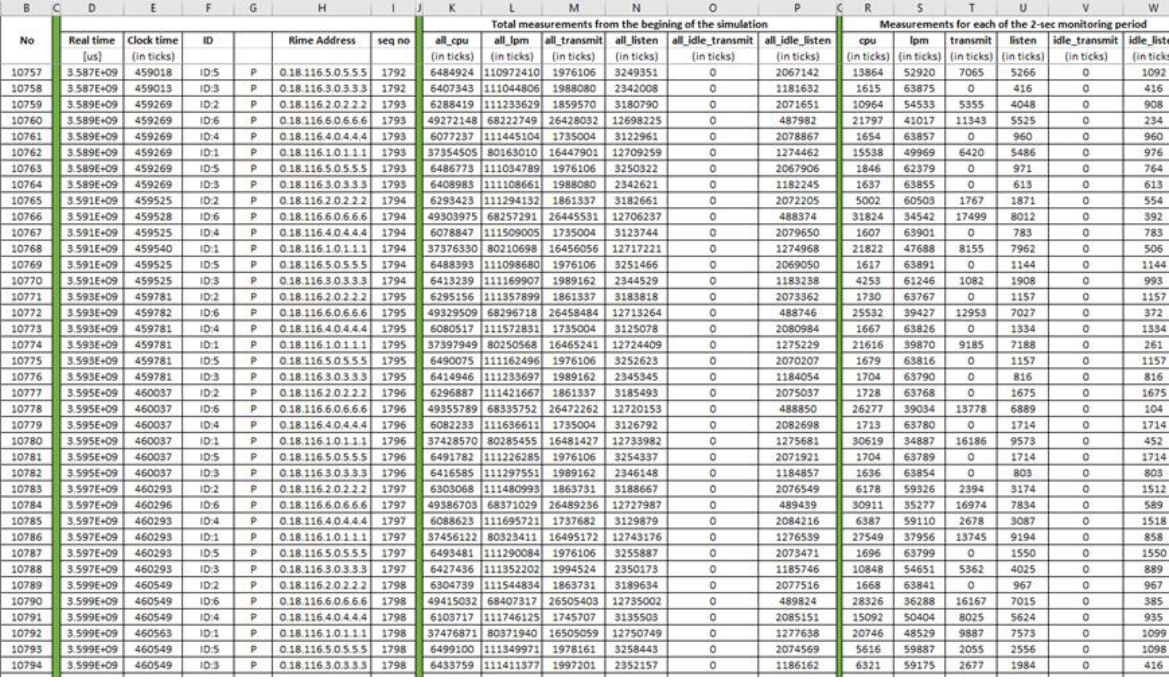
Figure 30. Malicious “recv.csv” — 1 to 27 records.